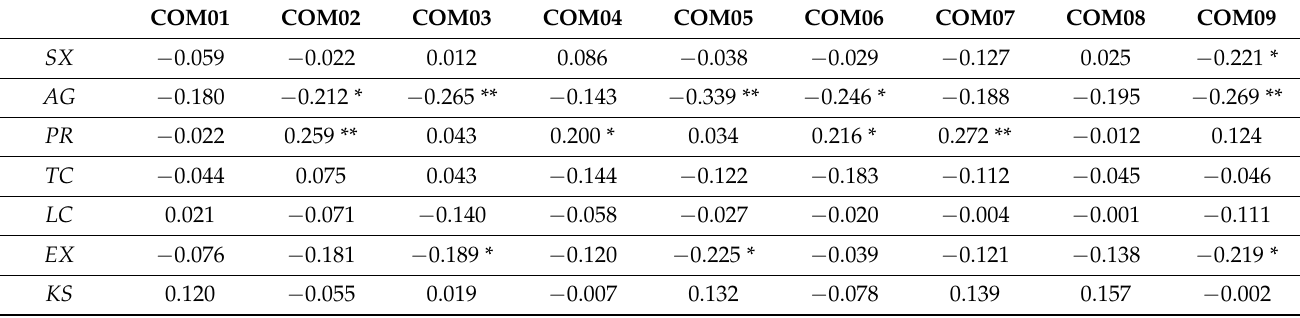
Table A10. Spearman correlation matrix: use of communication tools.